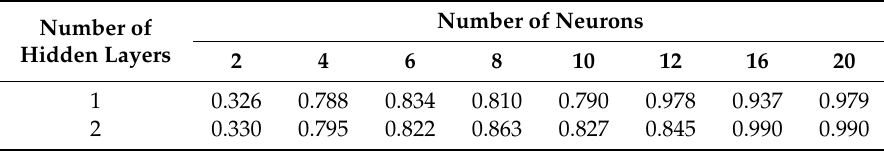
Table 4. The correlation coefficients, R 2 , for the validation data.